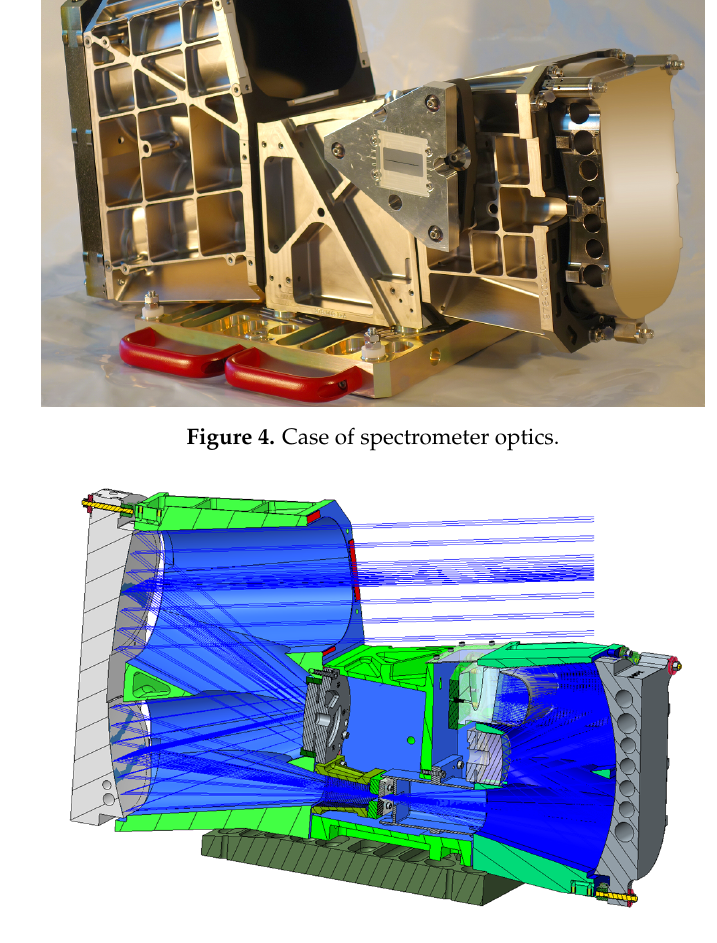
Figure 5. Cut-view of the DESIS opto-mechanical system. The Three-Mirror-Anastigmat (TMA) is on left side, and the spectrometer is on the right